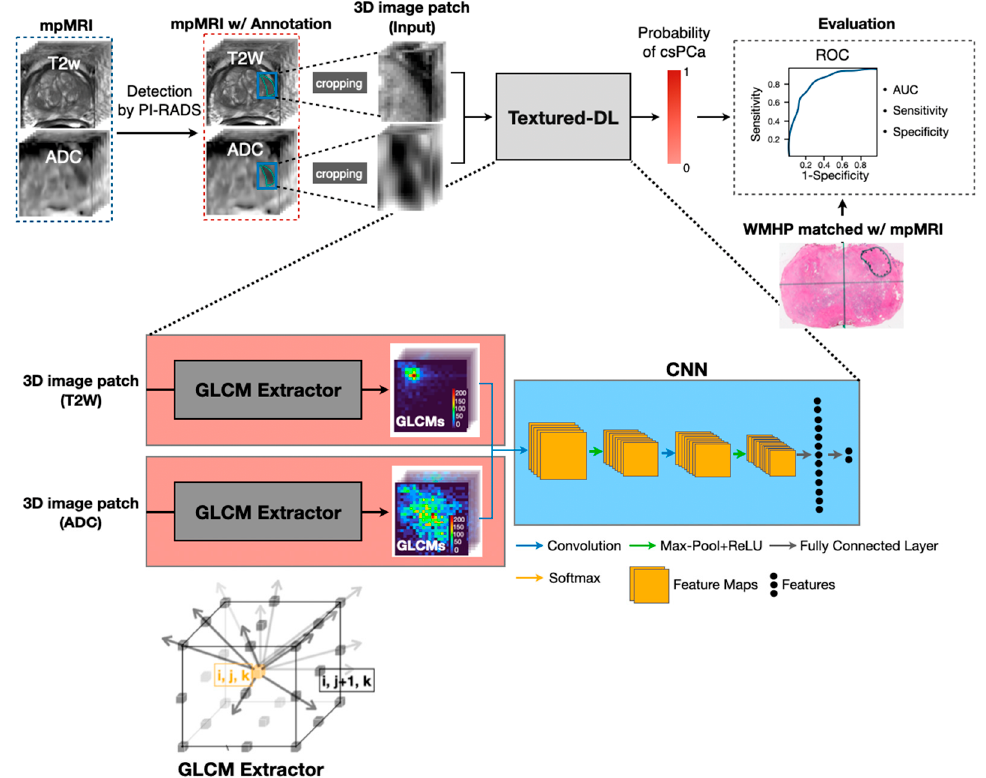
Figure 1. The overall workflow of the proposed Textured-DL model for the PCa classification. Suspicious prostate lesions were first detected and scored by the PI-RADS, followed by contouring. Then, 3D volumetric patches of the prostate lesion were cropped from the T2W and ADC images, and GLCM were extracted from two patches. Next, the two GLCMs were concatenated and fed into CNN to generate the probability of csPCa. ROC curve, AUC, sensitivity, and specificity were adopted to evaluate and compare the performance of PCa classification by the PI-RADS-CLA and Textured-DL, which was confirmed by the histopathological findings. In the GLCM extractor, each cubic box represents a voxel. The distance between adjacent voxels was enlarged to see the directions between voxels clearly. ( i , j , k ) is a voxel coordinate, and ( i , j + 1, k ) is an immediate neighboring voxel (INV) coordinate around the voxel.